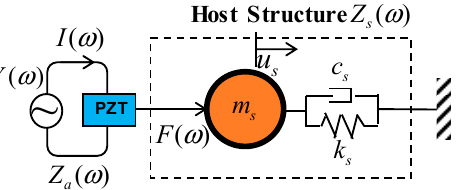
Figure 6. Scheme of the impedance-based SHM process.